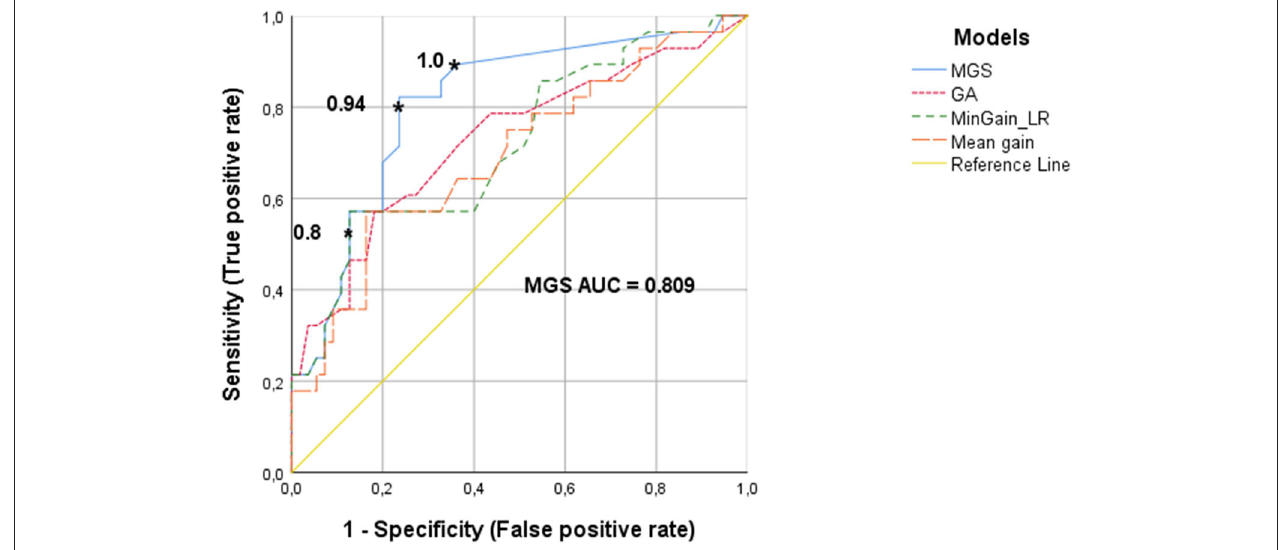
FIGURE 2 | ROC curves of the v-HIT for determining the need for an additional caloric test, using the parameters MGS (minimal gain & saccades), GA (gain asymmetry), MinGain_LR and mean gain. The asterisks show the cut-off values for the MGS parameter. The cut-off point of 0.8 resulted in 87% specificity and 49% sensitivity. The value 0.94 has a specificity of 76 and 80% sensitivity. The cut-off value of 1 has a specificity of 62% with a sensitivity of 90%.